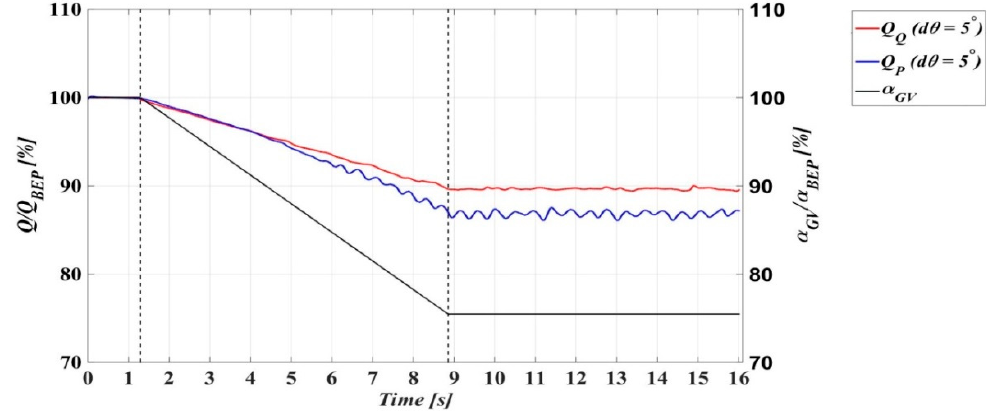
Figure 8. Time-dependent variation of the guide vane angle and discharge ( Q ) during the load variation. The dotted vertical lines represent the start and the end of the guide vane closure.